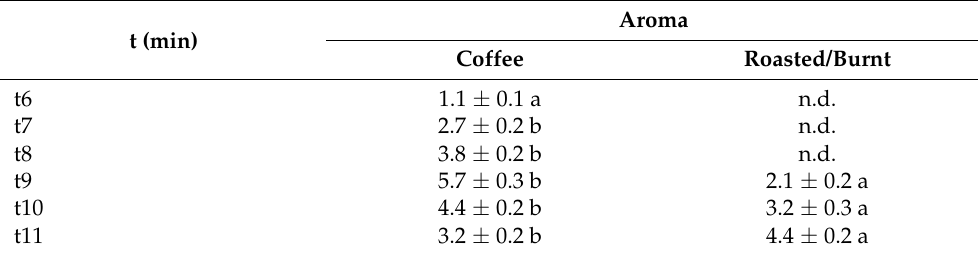
Table 3. Positive (coffee) and negative aromas (roasted/burnt) for roasted coffee beans submitted to different thermal treatments (t6–t11). Different lowercase letters mean statistically significant differences between samples submitted to different thermal treatments in each sensory attribute (one-way ANOVA followed by Tukey’s test, p < 0.05). n.d., not detected.